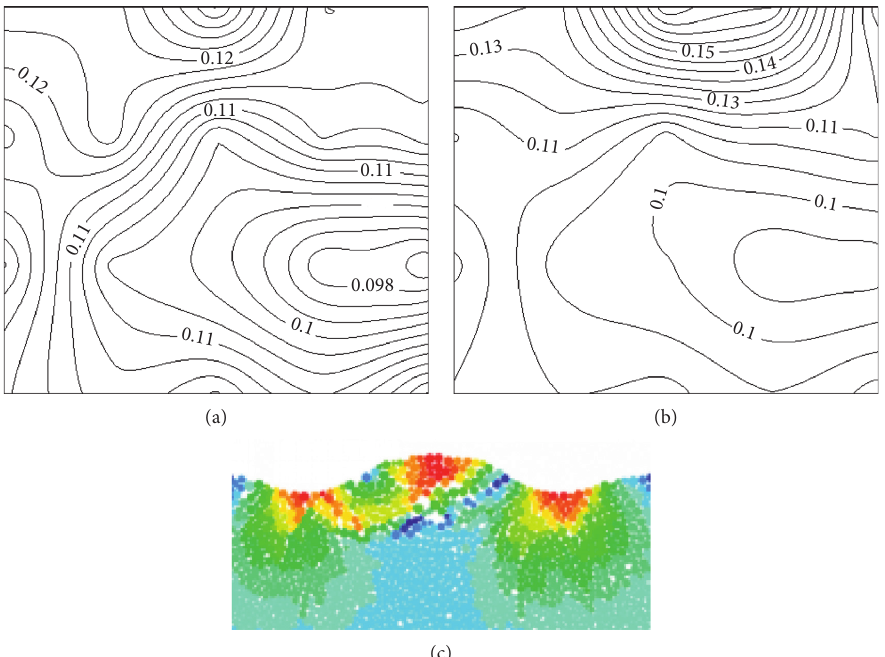
Figure 8: Contour line of porosity in soft soil particles. (a) Contour line of porosity at 2500 time steps. (b) Contour line of porosity at 7500 time steps. (c) Position state of particles at 10,000 time